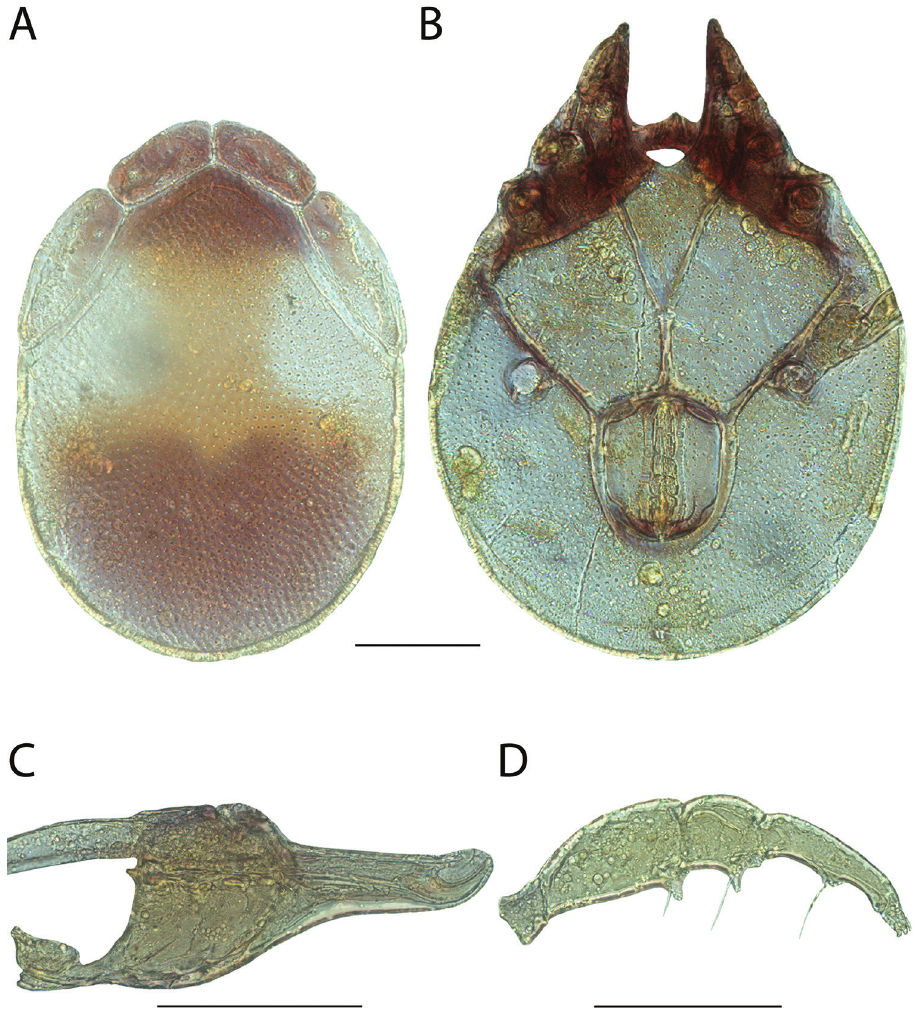
Figure 230. Torrenticola rufoalba male: A dorsal plates B venter (legs removed) C subcapitulum D pe- dipalp (setae not accurately depicted). Scale = 100